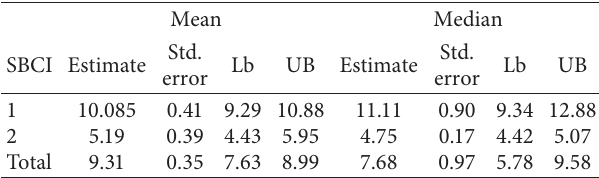
Table 4: Mean and median survival analysis times for SBCI.